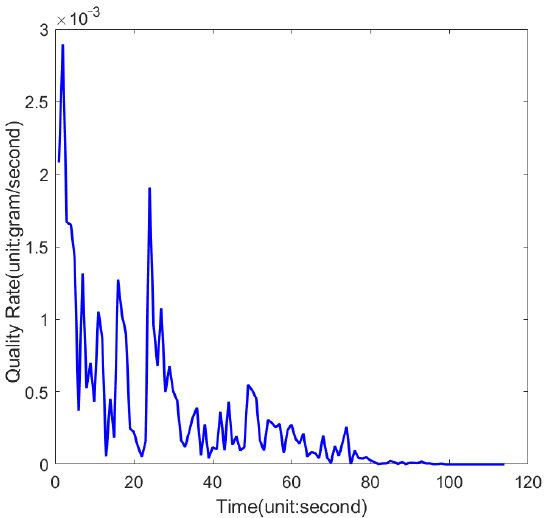
Figure 16. Graph of the change in mass rate of silicon dioxide at each moment during the melting process in the temperature cell. process in the temperature